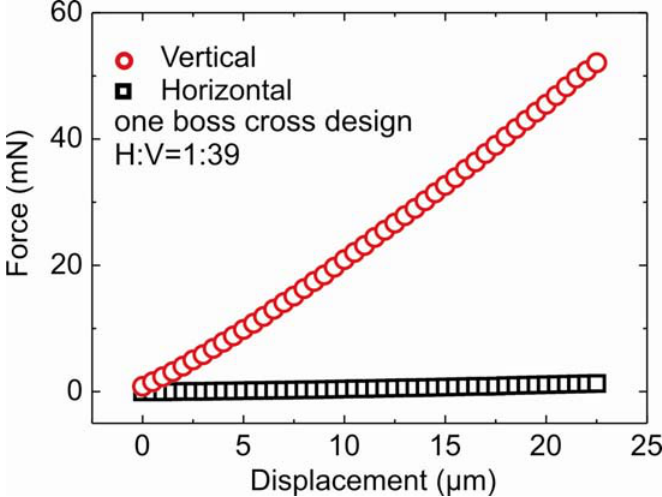
Figure 4 . Force vs displacement plot for one boss cross